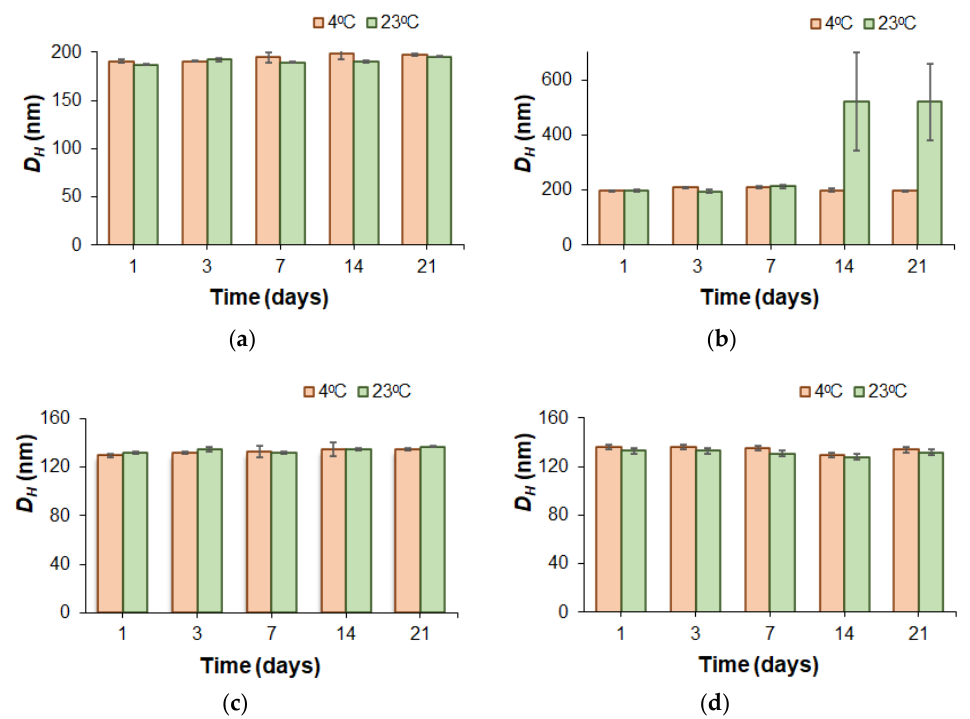
Figure 10. Storage stability of DOD/mPEG- b -PLA ( a , b ) and DOD/mPEG- b -PCL ( c , d ) nanomedi-